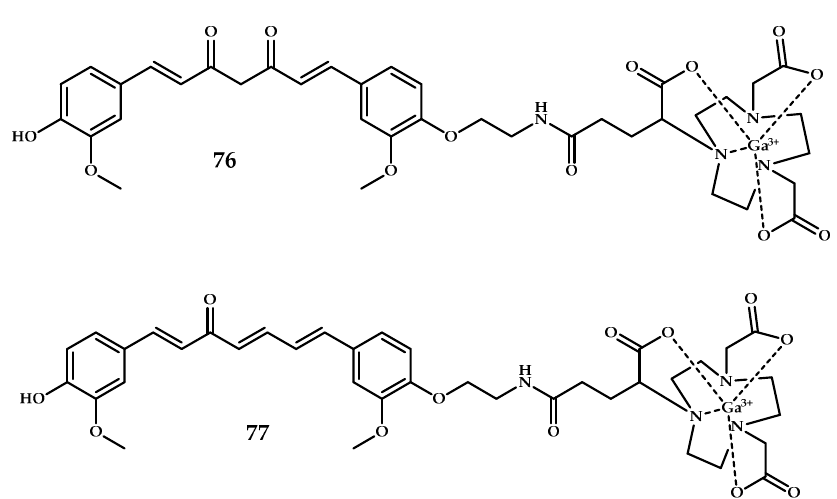
Figure 20. Curcumin-based Ga 3 + coordination compounds 76 and 77 with NODAGA and AAZTA Figure 20. Curcumin–based Ga 3+ coordination compounds 76 and 77 with NODAGA and AAZTA metal-chelating moieties, designed for PET imaging of A β plaques. metal-chelating moieties, designed for PET imaging of A β plaques.